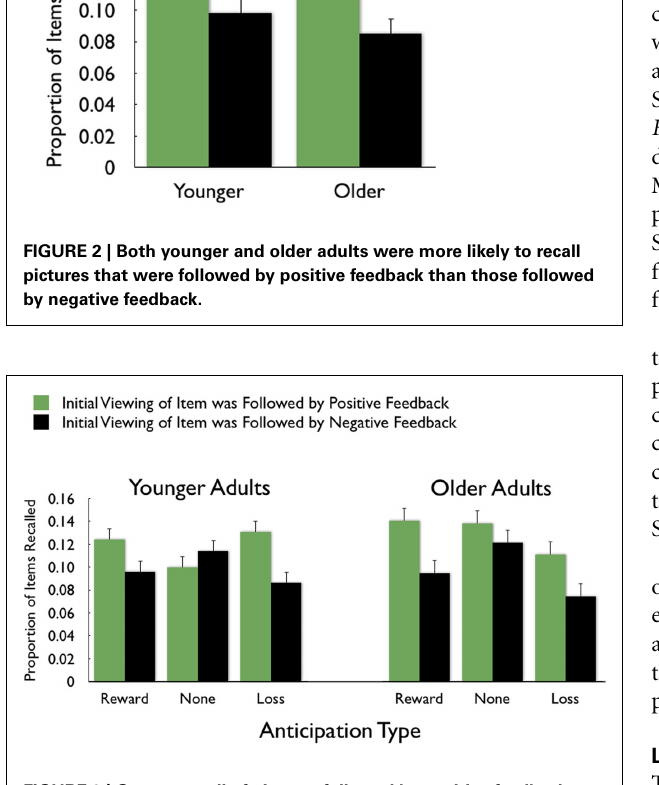
FIGURE 3 | Greater recall of pictures followed by positive feedback was seen for feedback associated with monetary outcomes more than for feedback with no monetary